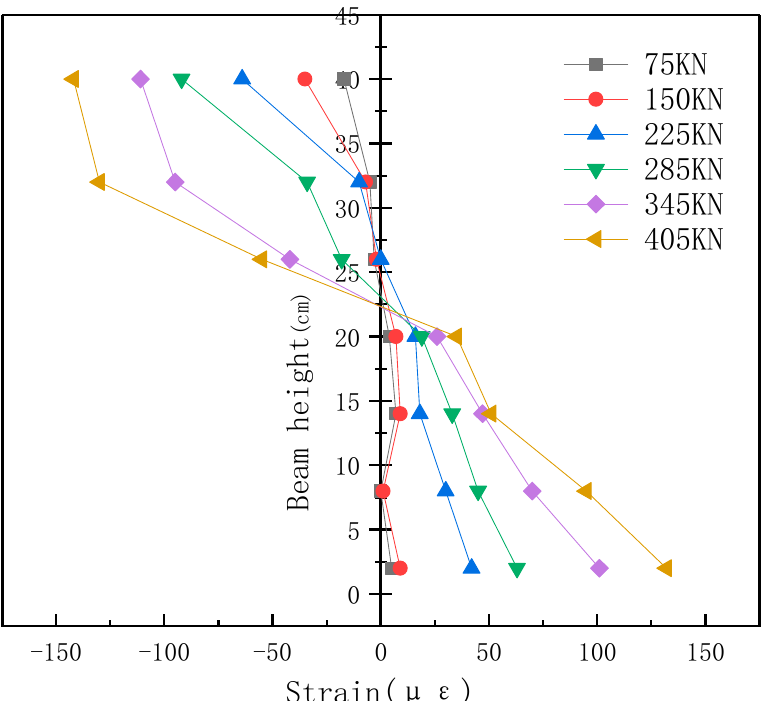
Figure 17. Strain of test beam L2 along beam height.